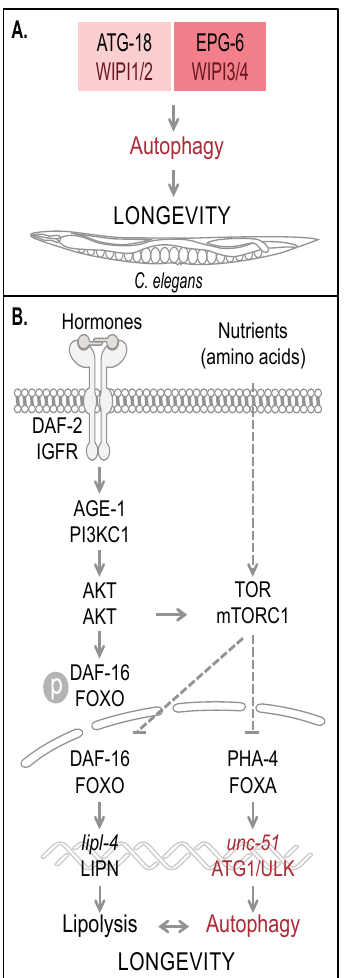
Figure 3. Autophagy and longevity control in C. elegans . The four human WIPI proteins are represented by two homologues, ATG-18 (homologue of WIPI1 and WIPI2) and EPG-6 (homologue of WIPI3 and WIPI4) in C. elegans , both of which are considered to be required for autophagy-controlled longevity ( A ). Hormones and nutrients (e.g. amino acids) control both autophagy and longevity in C. elegans ( B ). Upon hormone binding to and dimerization of DAF-2, the C. elegans orthologue of mammalian insulin/IGF-1 receptor (IGFR), AKT (also AKT in mammals) is activated via AGE-1 (PI3KC1 in mammals) to phosphorylate the transcription factor DAF-16. Phospho-DAF-16 is unable to localize to the nucleus. In the absence of AKT- mediated phosphorylation, DAF-16 localizes to the nucleus and fulfills its transcriptional transactivation activity on a large subset of genes controlling stress resistance and survival, by upregulation of mediators required for detoxification, anti-inflammation and lipolysis (lipl-4, LIPN in mammals). DAF-16 is further critically controlled by TOR (mTOR in mammals, a well- known target of AKT-mediated signaling). Upon nutrient availability (e.g. amino acids), TOR inhibits both transcription factors DAF-16 and PHA-4 (FOXA in mammals). Subsequently unc- 51 (ATG1 in yeast and ULK in mammals) transcription is inhibited, preventing full autophagic activity. Interdependently, lipolysis and autophagy control longevity in C. elegans. The schematic drawings of C. elegans , plasma membrane, receptor, nuclear envelope and DNA were obtained from